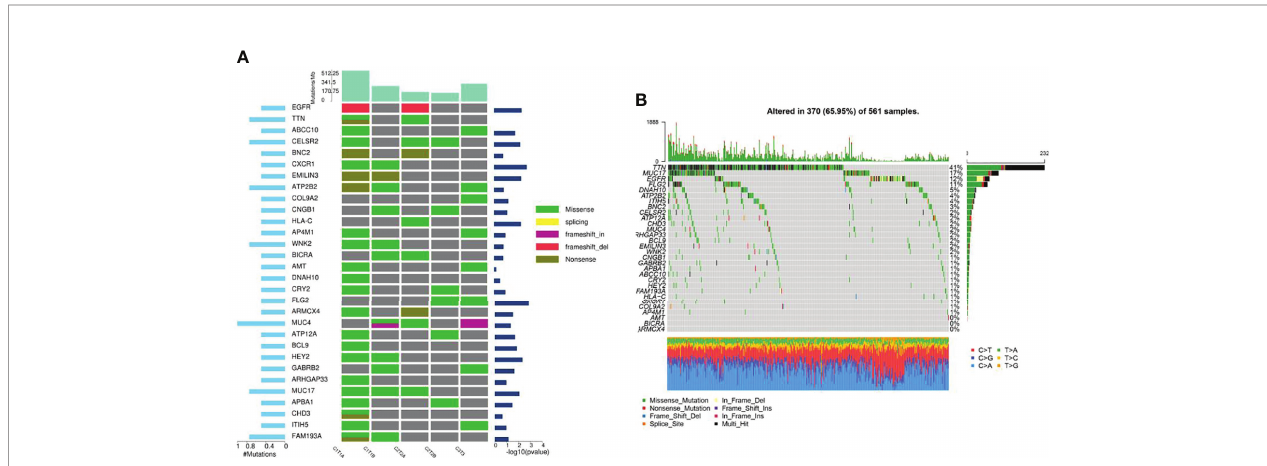
FIGURE 3 | Gene mutation characteristics of three patients and in TCGA database. (A) High-frequency mutation genes of three lung adenocarcinoma patients; (B) Mutation spectrum of high-frequency mutation genes in TCGA mutation